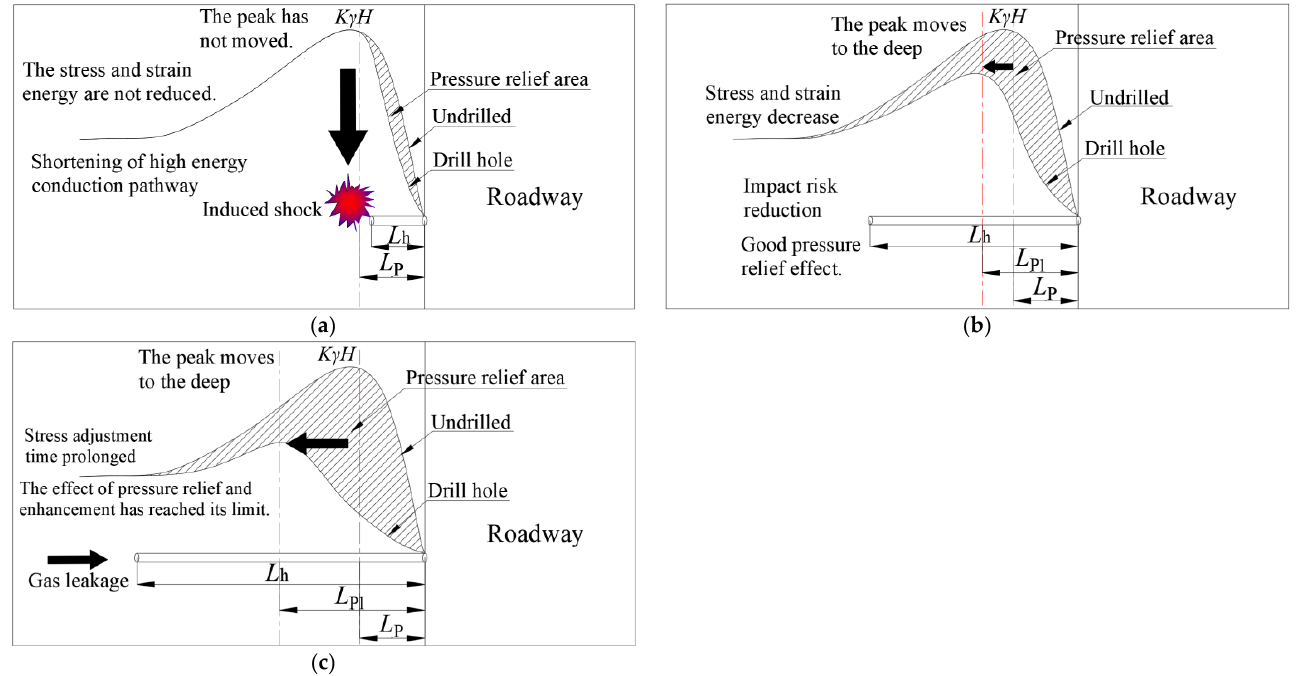
Figure 10. Analysis model of drilling length. ( a ) L h ≤ L P . ( b ) L P < L h ≤ 2.5 L P . ( c ) L h > 2.5 L P .